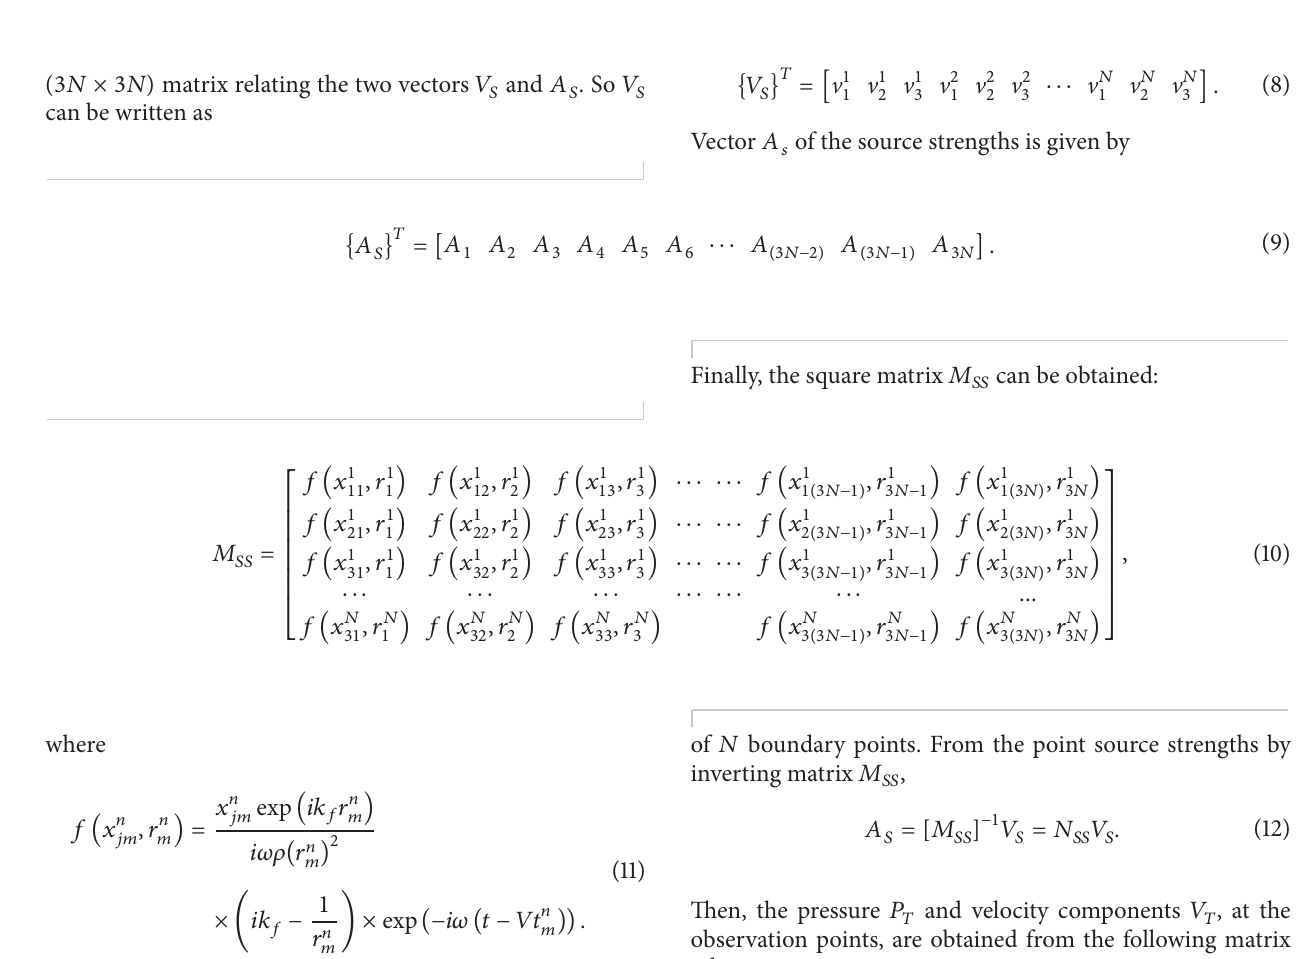
Figure 1: Geometric model of